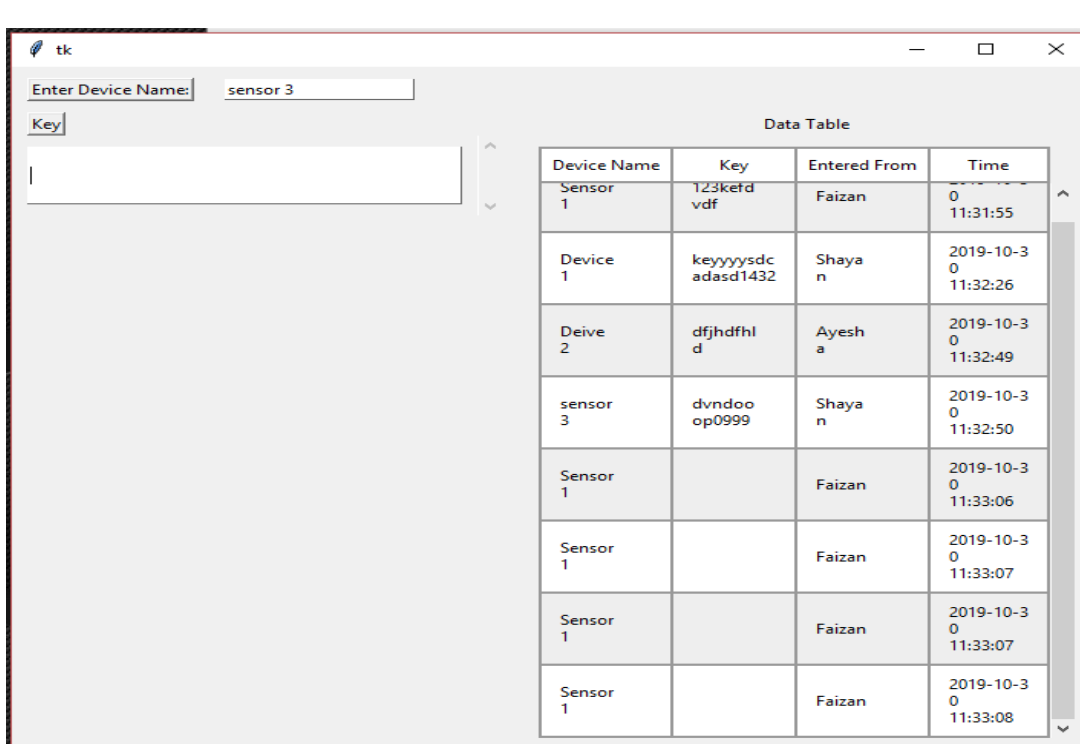
Figure 7. Hash of record entered by the new node.